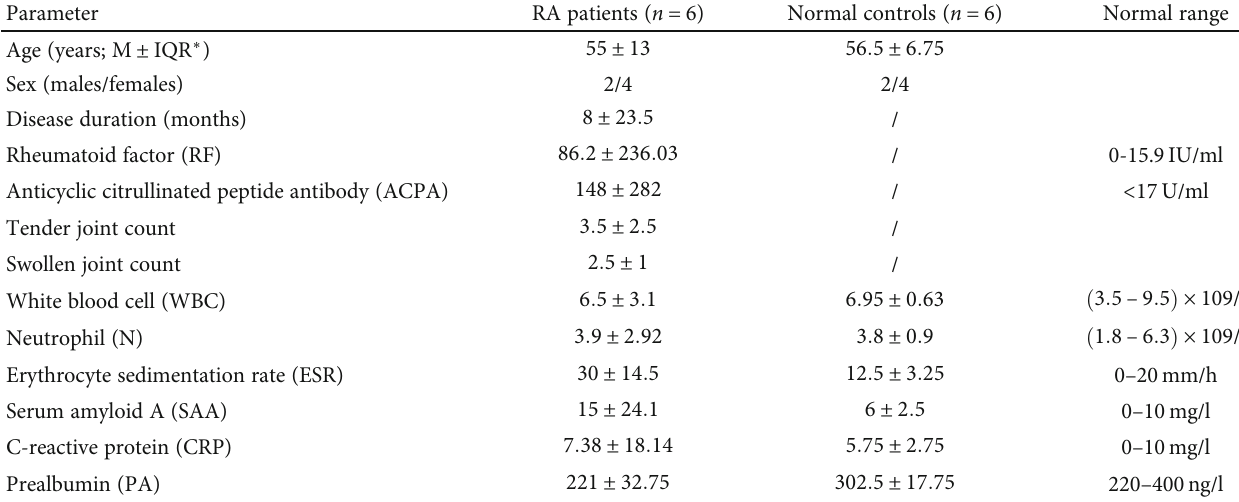
Table 1: Demographic and clinical data of patients with rheumatoid arthritis and healthy controls.